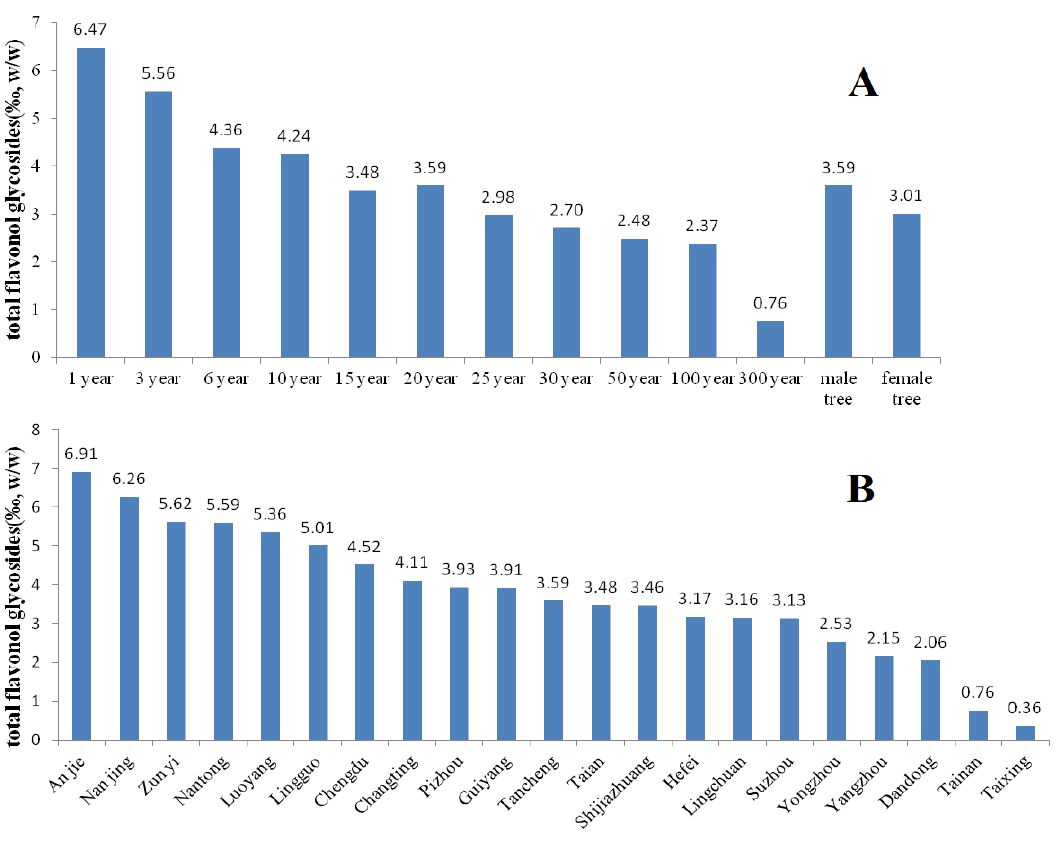
Figure 4. Comparison of the total flavonol glycosides in the G. biloba leaves collected from different ages (A), cultivation sources (B) and genders